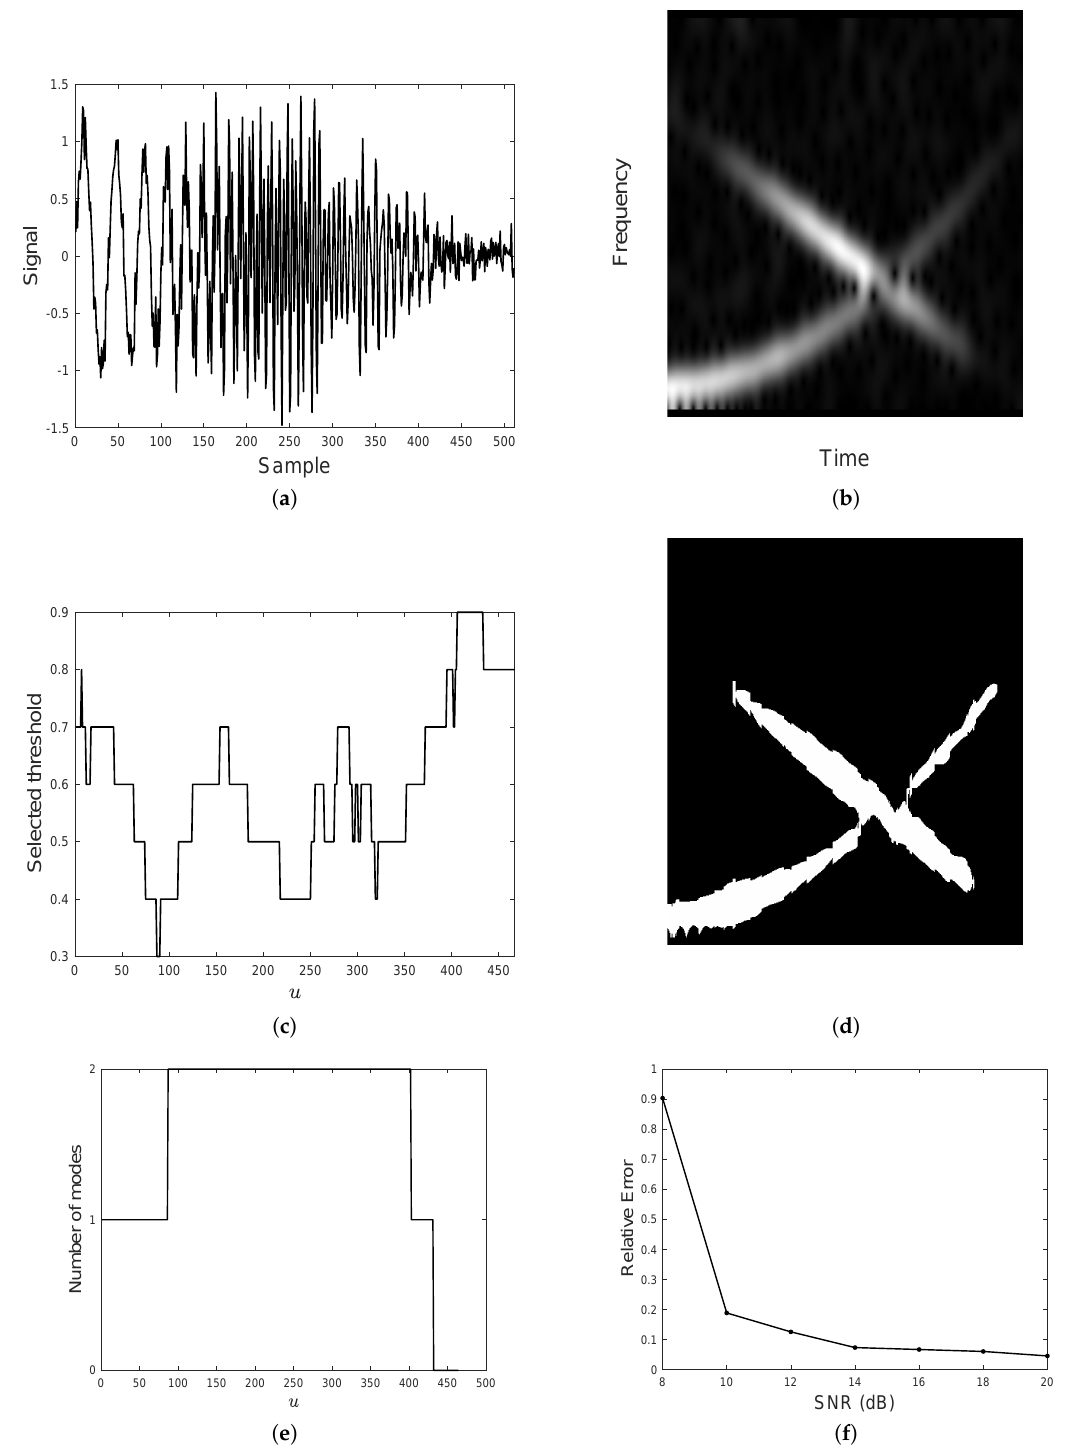
Figure 15. ( a ) Two-component noisy AM–FM signal composed of a quadratic and a linear chirp, respectively with linear and gaussian amplitudes, SNR = 15 dB. ( b ) Spectrogram of ( a ), s = 46. ( c ) Optimal threshold provided by MDL functional minimization, according to Equation (18). ( d ) Binary map derived from ( b ). ( e ) Estimated number of modes. ( f ) Relative counting error against